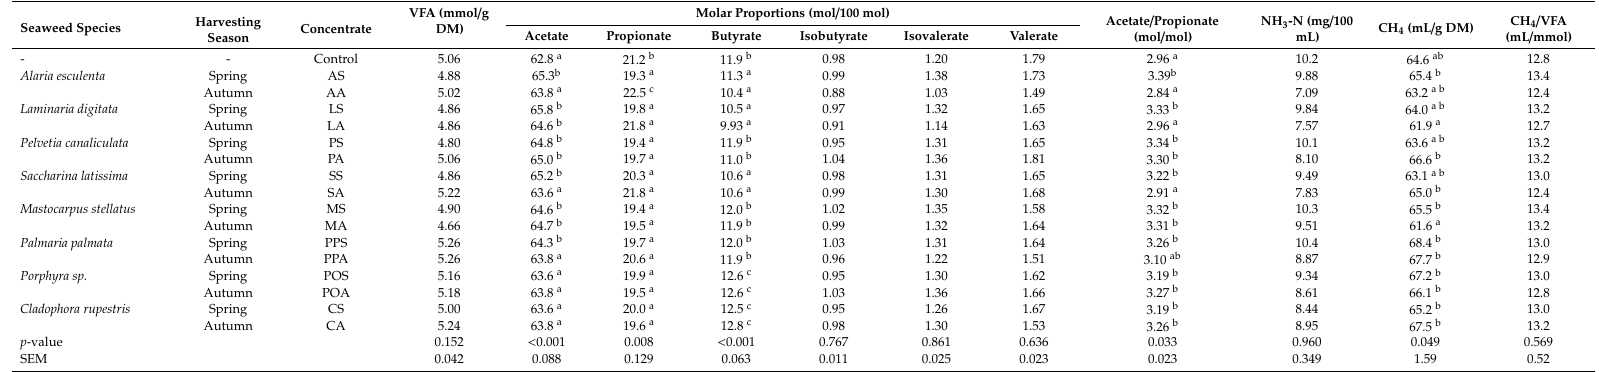
Table 7. Fermentation parameters after 24 h of in vitro incubation of diets containing 50% of oat hay and 50% of concentrate either including no seaweeds (control) or di ff erent seaweed species harvested in spring and autumn in northern Norway 1